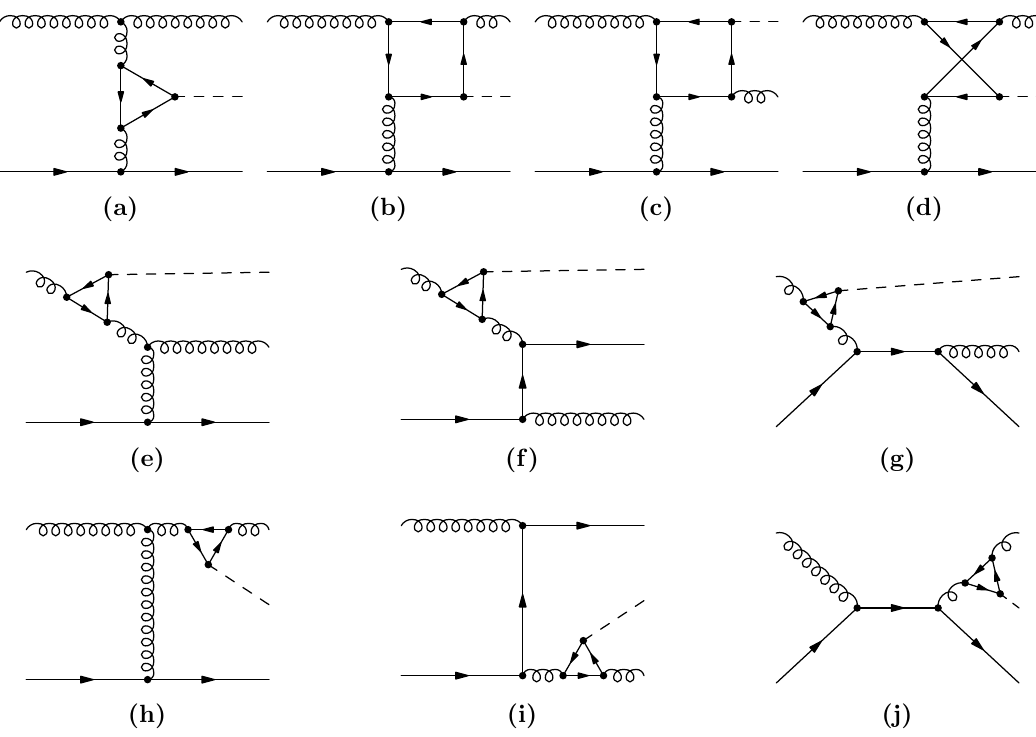
gHq . Diagrams with clock- !